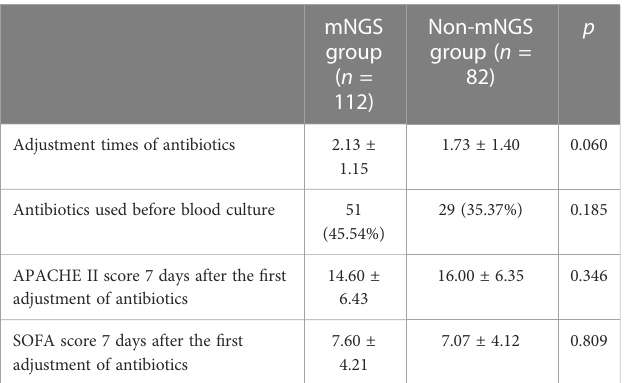
TABLE 2 Clinical medication guidance between mNGS group and non- mNGS group.